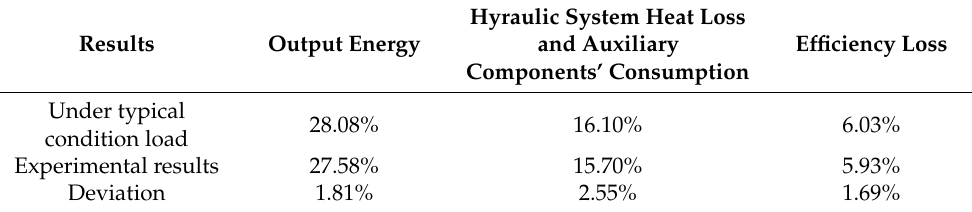
Table 5. Hydraulic pump energy flow results comparison under operation conditions.